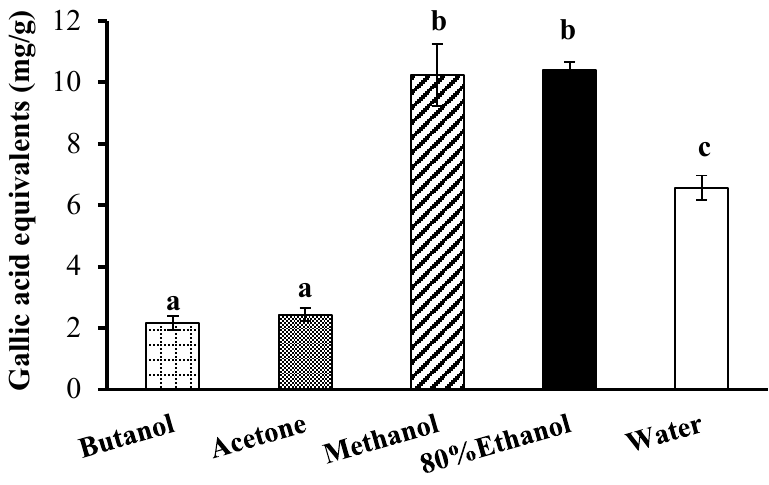
Figure 2. Total phenolic content of bitter melon extracts obtained with five solvents. Values are means ± standard deviations ( n = 3) and those not sharing a superscript letter are significantly different ( p < 0.05) from each other.